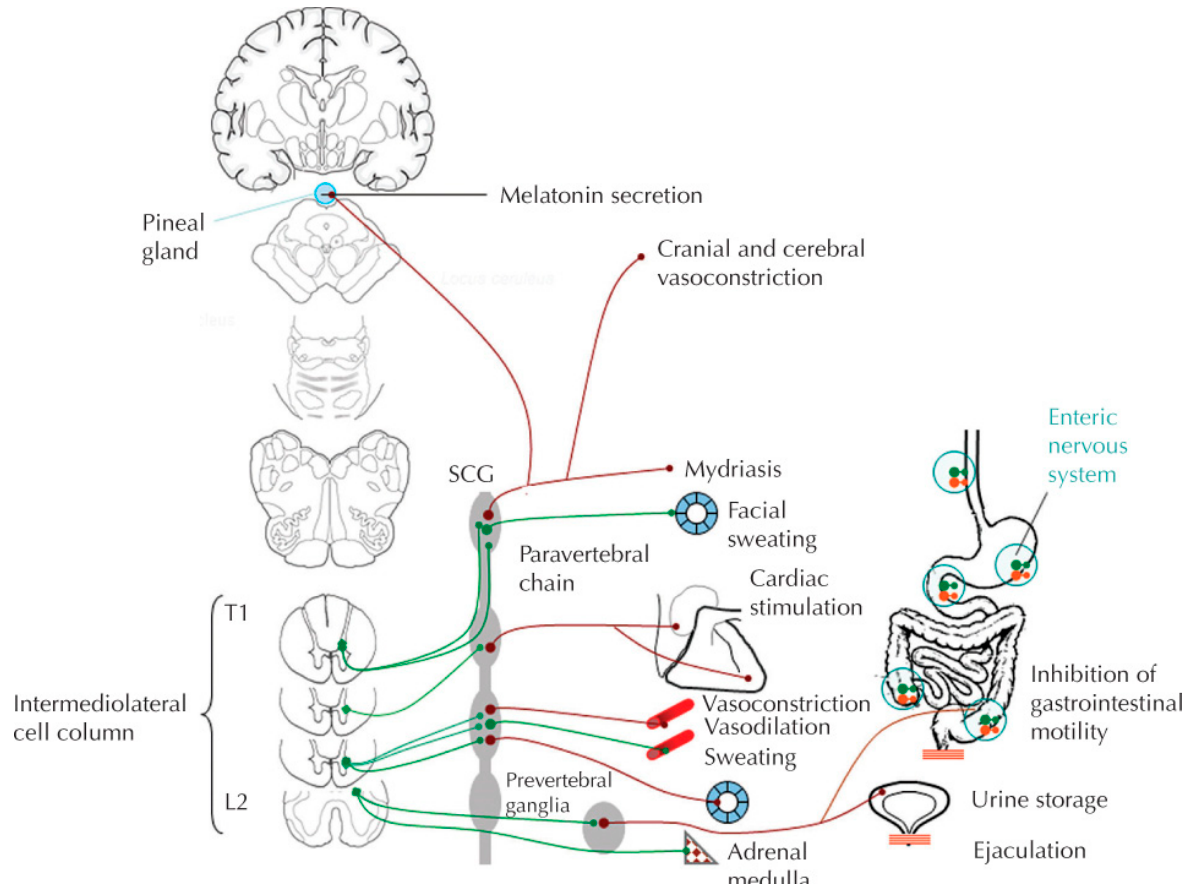
Figure 1. Main effectors and effects of the sympathetic system. The effects of the sympathetic system are mediated by neurons of the paravertebral and prevertebral ganglia and by the adrenal medulla. SCG, superior cervical ganglion. With permission from E.E. Benarroch. Autonomic Neurology. Oxford University Press. NY, NY. © Mayo Foundation for Medical Education and Research 2014.